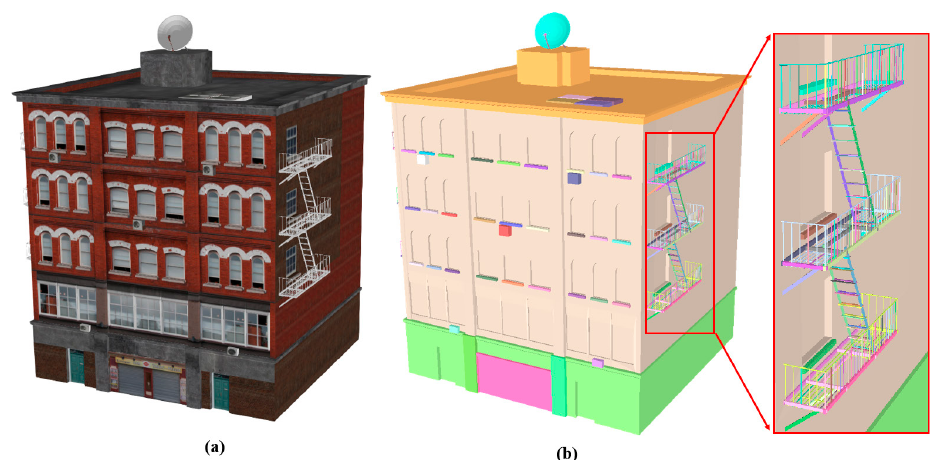
Figure 3. Mesh segmentation results: ( a ) original 3D building model, and ( b ) mesh segmentation results. The stairs have rich details and are made up of several components.